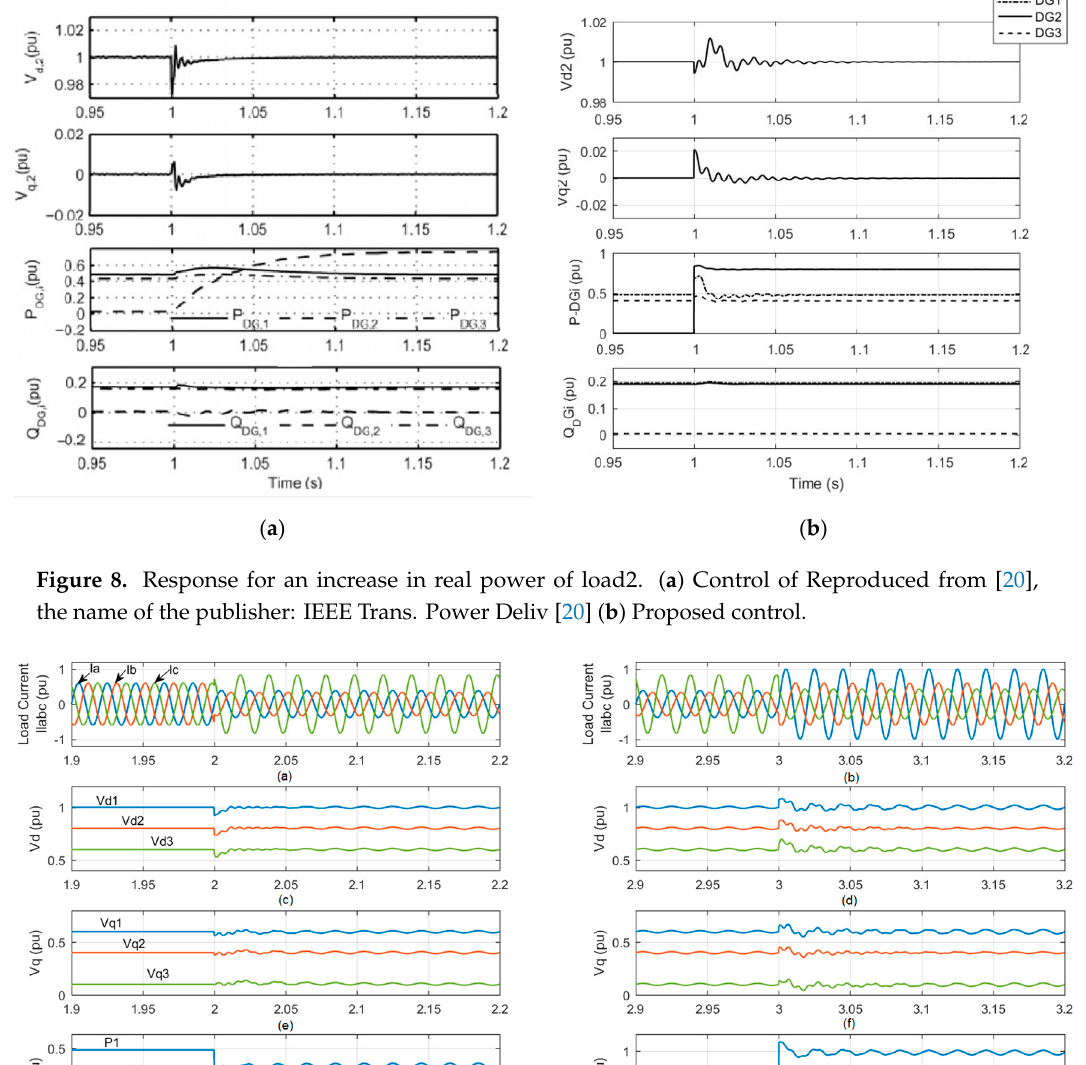
Figure 9. Dynamic performances of DG 1, DG 2, and DG 3 during islanded micro-grid and unbalance load condition. ( a ) load currents, unbalance at t = 2 s, ( b ) load currents, unbalance at t = 3 s, ( c ) V d at PCC, unbalance at t = 2 s, ( d ) V d at PCC, unbalance at t = 3 s, ( e ) V q at PCC, unbalance at t = 2 s, ( f ) V q at PCC, unbalance at t = 3 s, ( g ) active power, unbalance at t = 2 s, ( h ) active power, unbalance at t = 3 s.